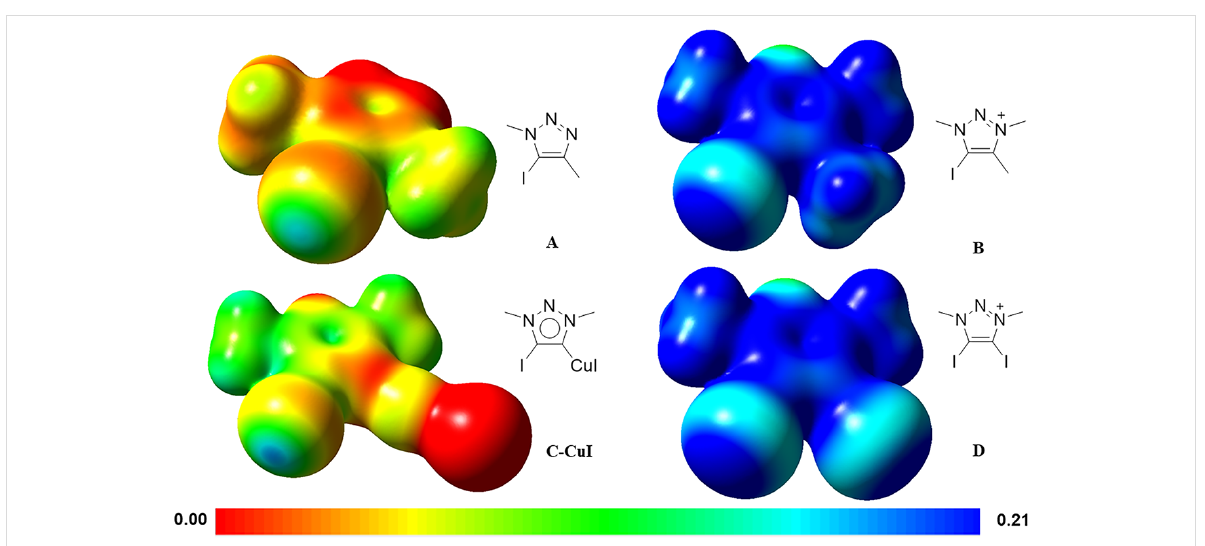
hole of in diiodotriazolium D and 1,2,3-triazolium B are compa- rable, and much larger than the 1,2,3-triazole A and 1,2,3-tri- azolylidene complex C-CuI due to positive charge